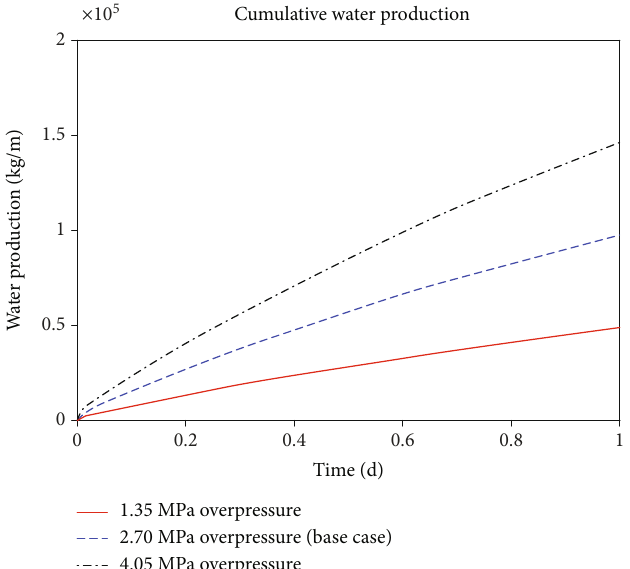
Figure 8: Cumulative water production at the wellbore during one day of shallow water fl ow for overpressure sensitivity.